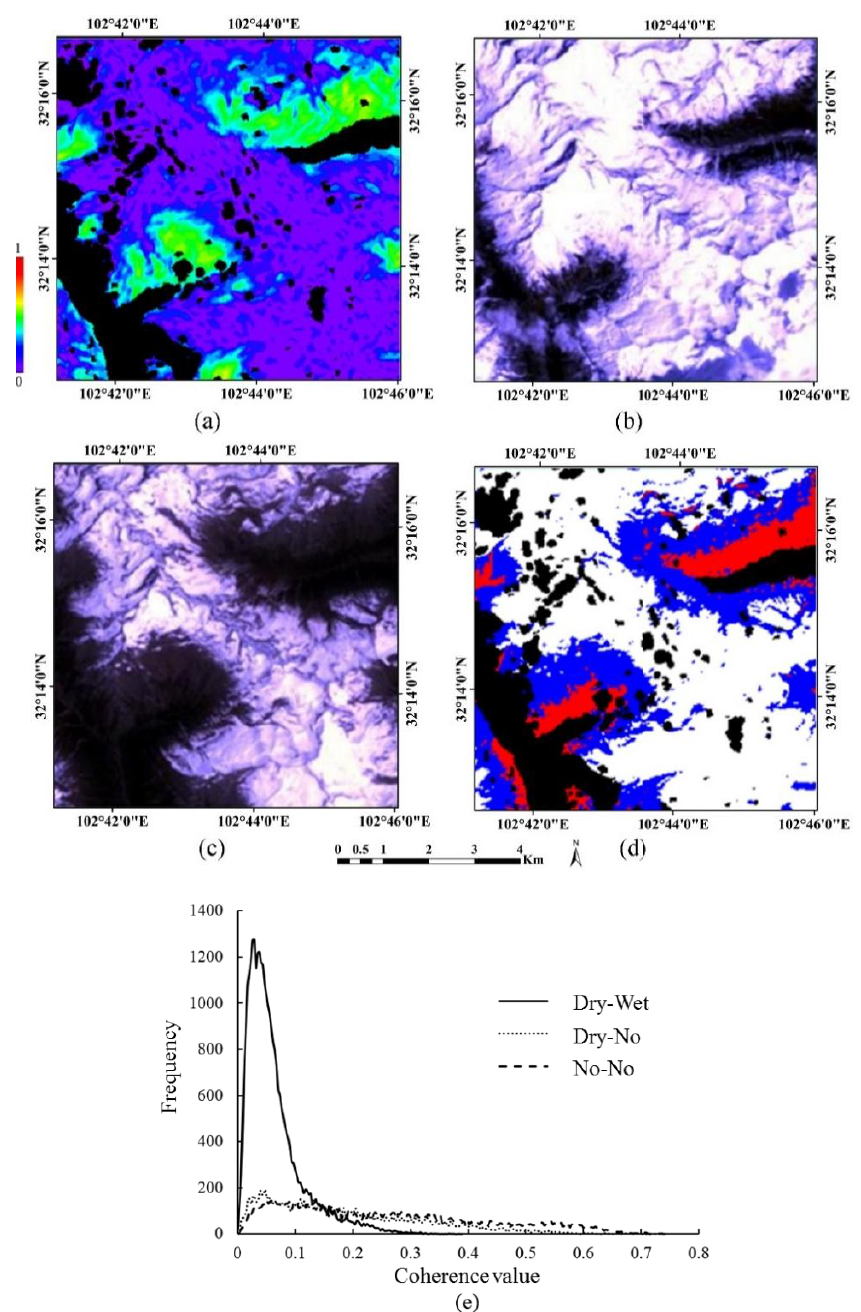
Figure 5. ( a ) Temporal-coherence component of a sample area extracted from 20080408–20080524 pair. ( b ) A true color composite of Landsat 5 TM data acquired on 4 April 2008. ( c ) A true color composite of TM data acquired on 5 May 2008. ( d ) Snow changes that occurred between 4 April and 15 May of 2008. Areas in white were snow-covered area. Areas in blue indicated that the snow was completely melted from April to May. Areas in red were no-snow on both dates. ( e ) The histogram of (a) categorized by each type of snow changes was derived from (d). The marked out areas were in black in (a) and